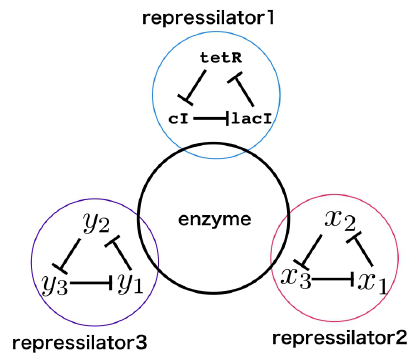
Figure 1. General design of the system: three identical reaction networks (repressilators) are im- plemented with independent molecular species, while sharing the same enzymes. Each network is made of three species being continuously produced by the system while repressing the creation of the next species in the cycle. Direct interactions are prevented and coupling can only occur through competition for enzymatic